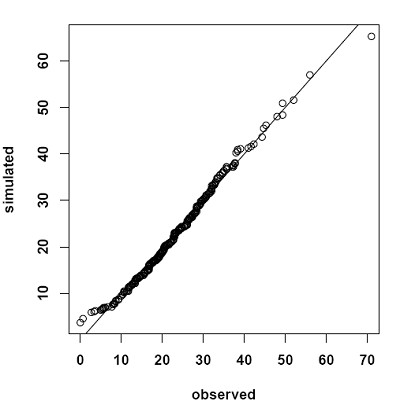
Simulated versus observed Alzheimer Disease Assessment Scale - cognitive subscale data. Quantile-quantile plot of simulated versus observed Alzheimer Disease Assessment Scale - cognitive subscale total scores at month 24.